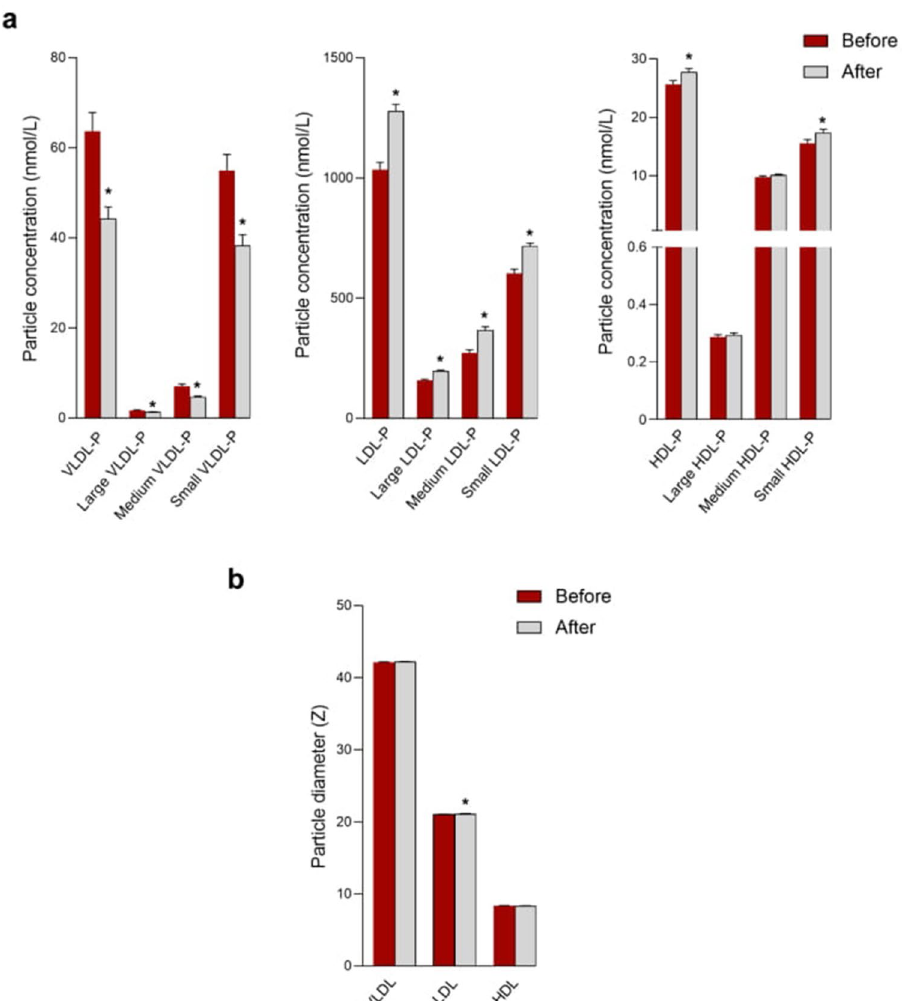
Figure 2. Concentration and diameter of particles of each subclass of lipoproteins pre- and post-surgery (n = 51). Results are shown as means and standard errors. Asterisks denote significance (*p ≤ 0.05) by Wilcoxon signed-rank test. HDL high-density lipoproteins; IDL intermediate-density lipoproteins; LDL low- density lipoproteins; LSG laparoscopic sleeve gastrectomy; P particle concentration; VLDL very-low-density lipoproteins; Z particle